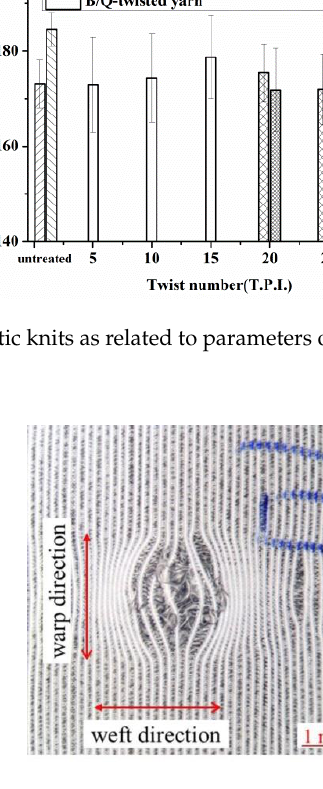
Figure 9. Images of the fractured elastic knits after the bursting strength test. As all samples exhibit similar failure over the surface, B/Q-twisted yarns made of 20 T.P.I. is used in this diagram.